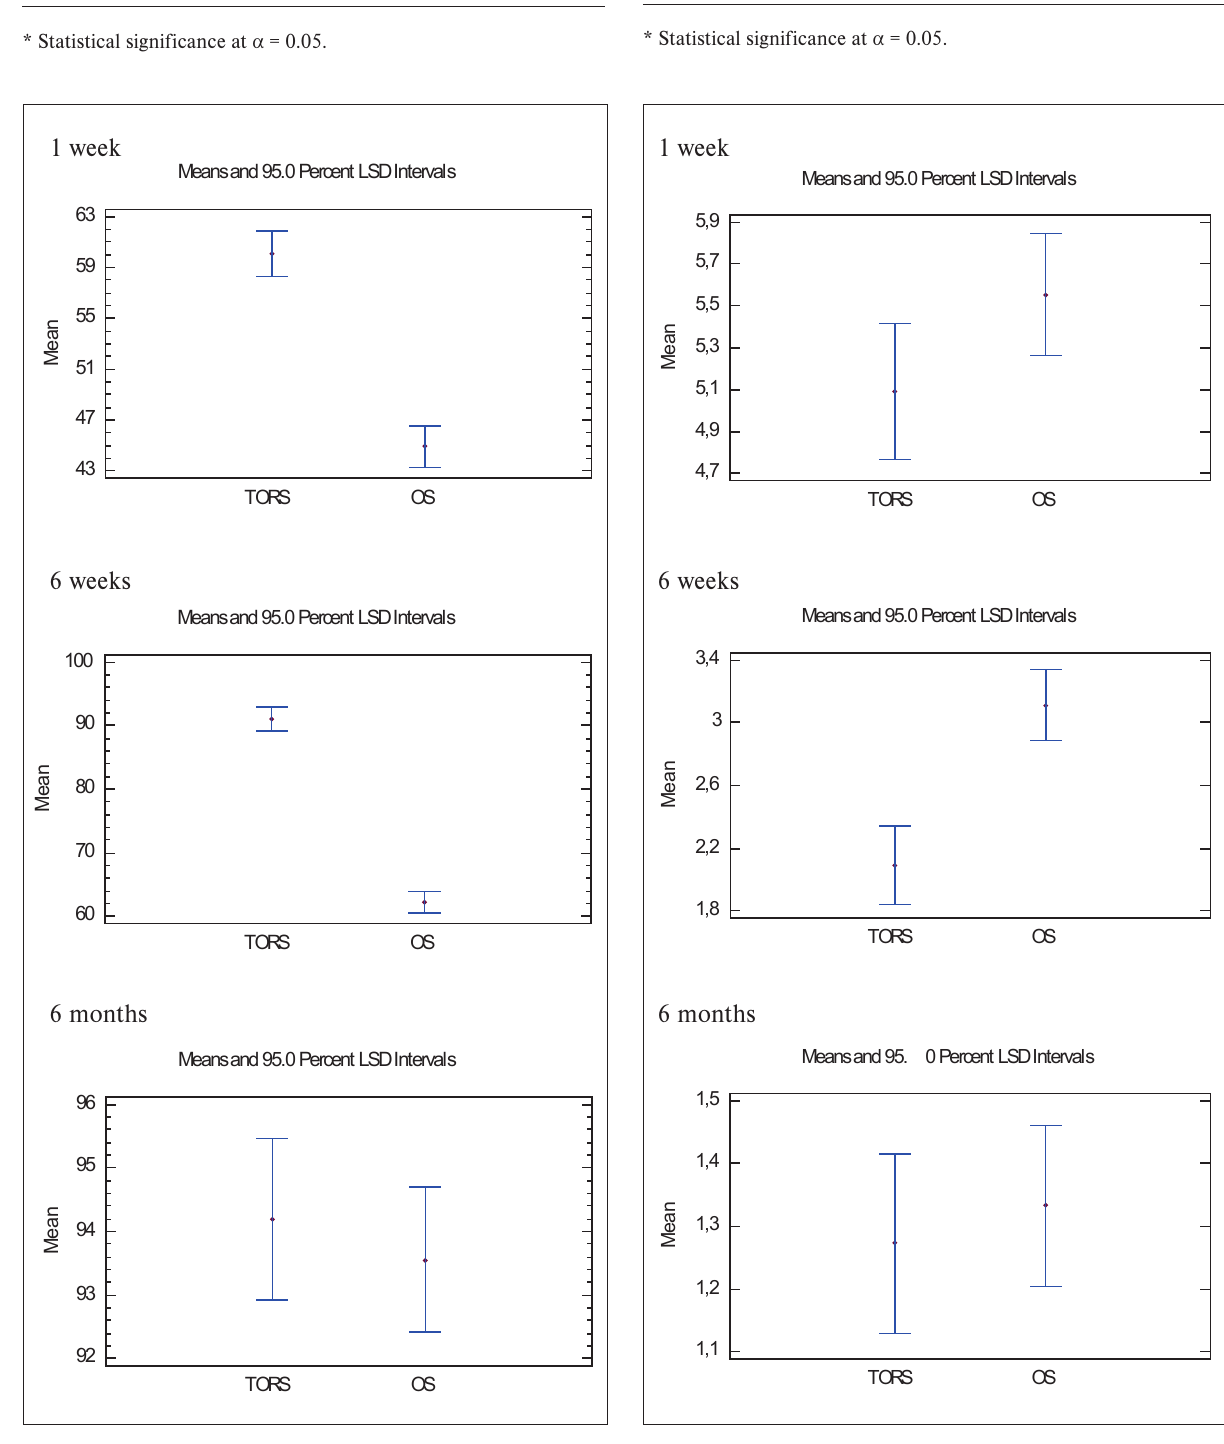
Fig. 2. mdadi scores in the selected intervals Tors and os.